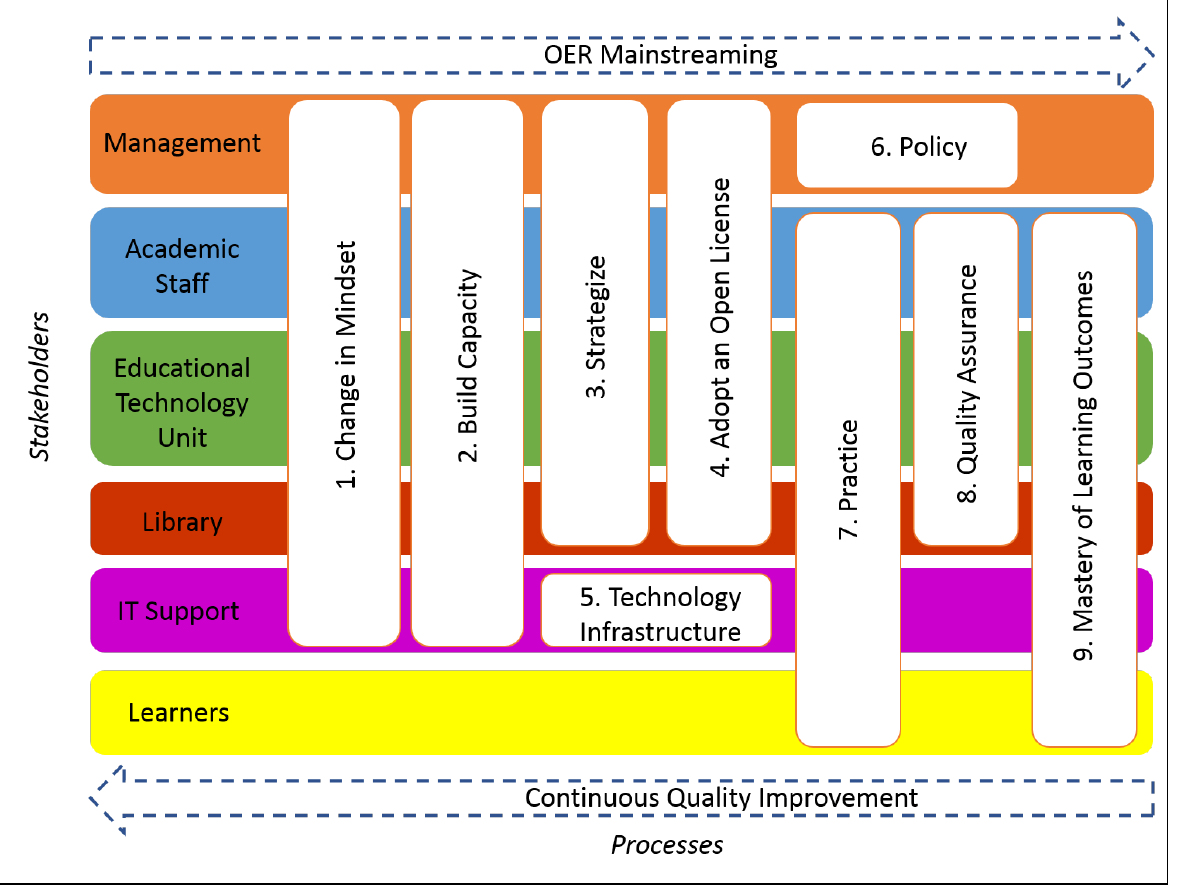
Figure 1. Horizontal framework for OER mainstreaming in an institution. Adapted from “An empirical framework for mainstreaming OER in an academic institution,” by I.S. Abeywardena, 2017, Asian Association of Open Universities Journal, 12(2) , p. 232 . CC BY 4.0.